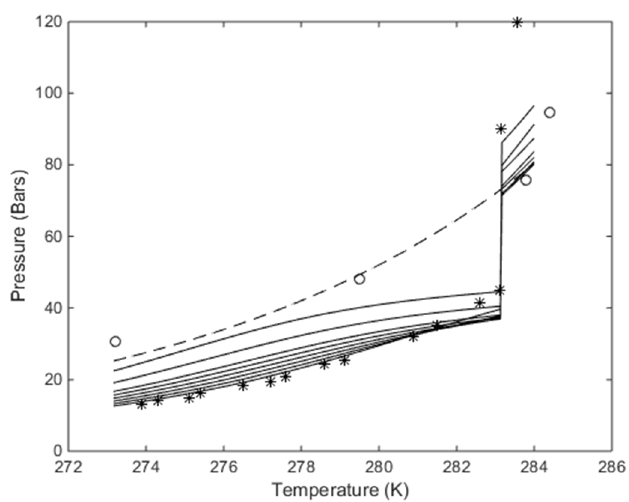
Figure 15. Calculated stability limits for hydrate in temperature pressure projection of the hydrate stability window. Lowest solid curve is for pure CO 2 , followed by 95 mole per cent CO 2 , then 90 mole per cent CO 2, , then 85 mole per cent CO 2 , then 80 mole per cent CO 2 , then 75 mole per cent CO 2 , then 70 mole per cent CO 2 , then 60 mole per cent CO 2 and upper solid curve for 50 mole per cent CO 2 . The circles are experimental data from [54] for 50 mole per cent CO 2 , and as such to be compared to the highest solid curve. The stars are experimental data for pure CO2 [55] and as such comparable to the lowest solid curve. Dashed curve is for temperature pressure stability limits for CH 4 hydrate.